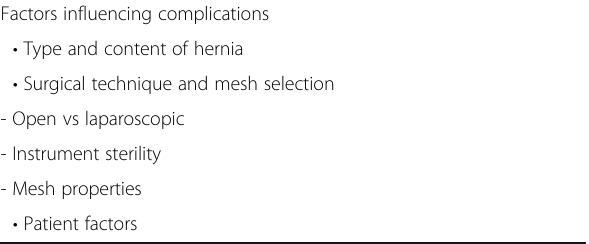
Table 2 Factors influencing complications Factors influencing